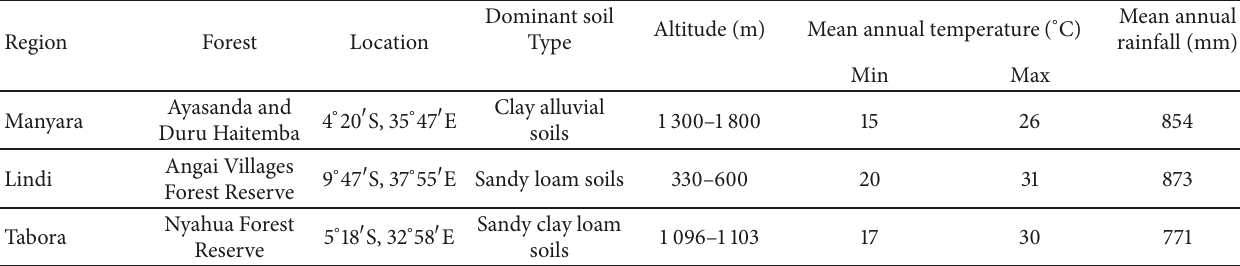
Table 1: Study sites descriptions.